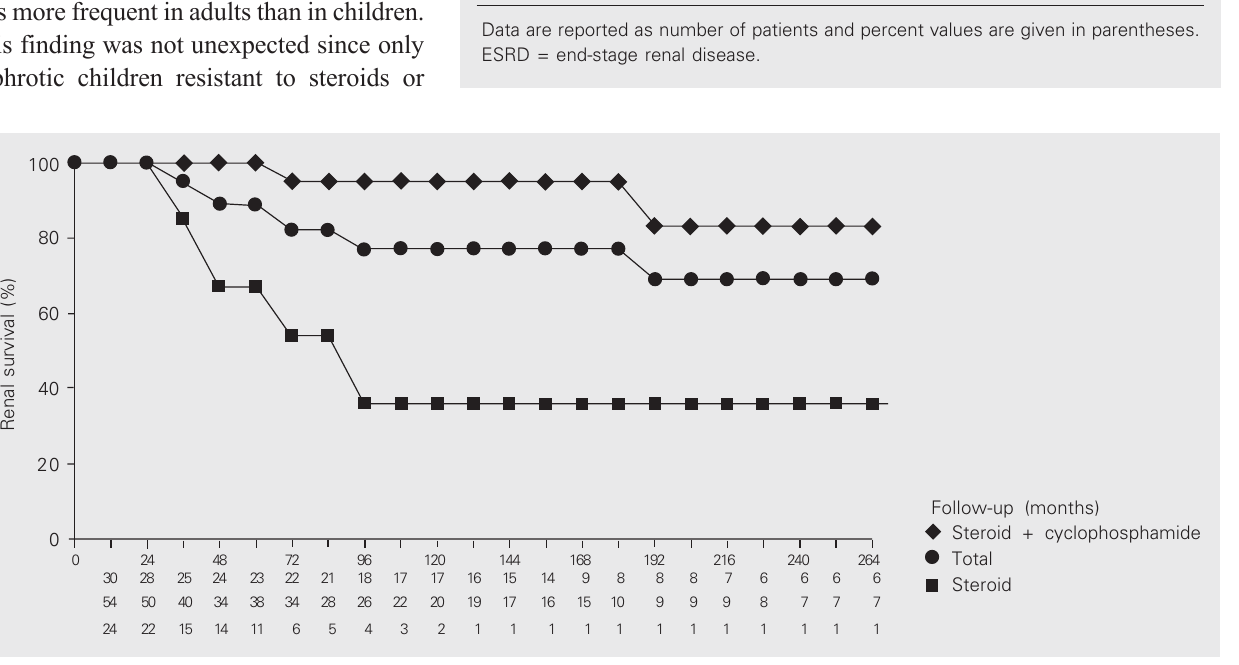
Figure 1. Renal survival of patients with focal segmental glomerulosclerosis and nephrotic syndrome treated with immunosup- pressive agents. Number of patients reported at bottom of